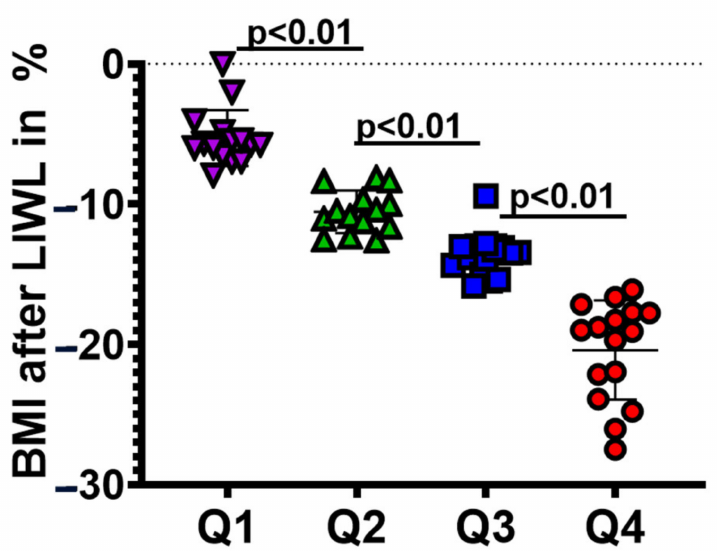
Figure 2. Division of study participants into four quartiles based on initial weight loss. Q1 represents the 25% of individuals with the lowest levels of weight loss. Differences between groups were analyzed by the Mann-Whitney U